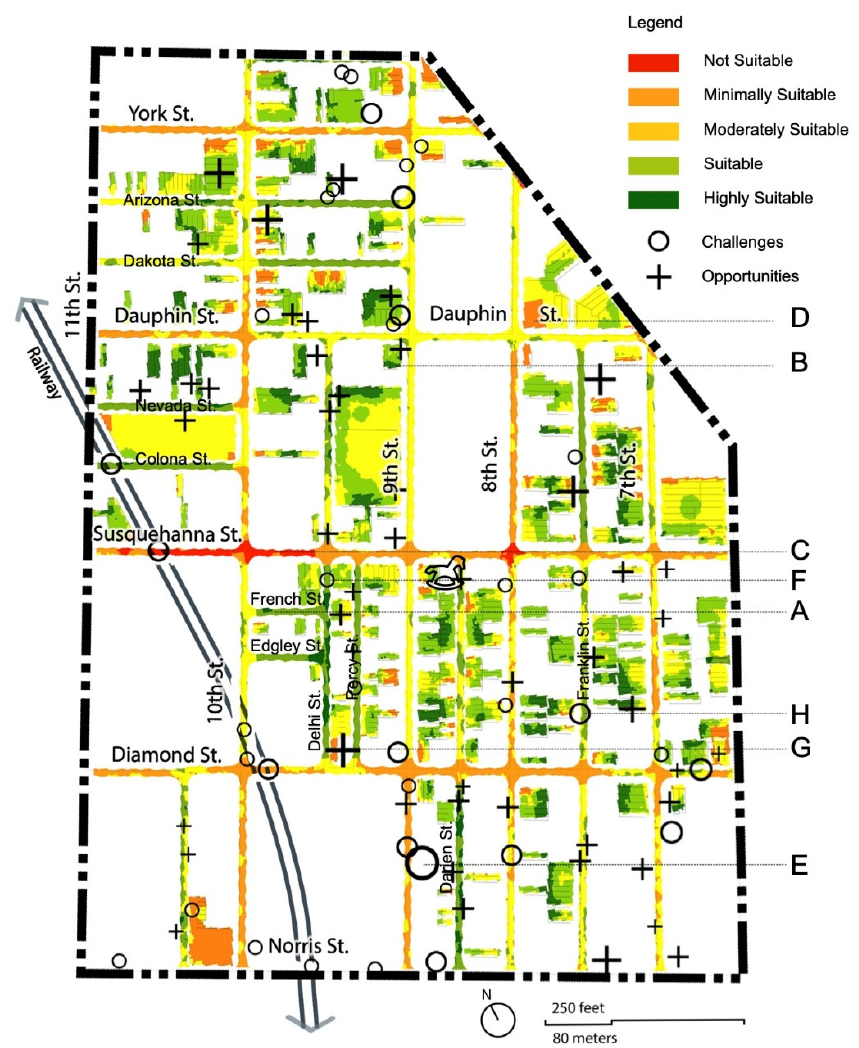
Figure 7. The Final suitability map—An Overlay of the Observation and Tacit Knowledge map.